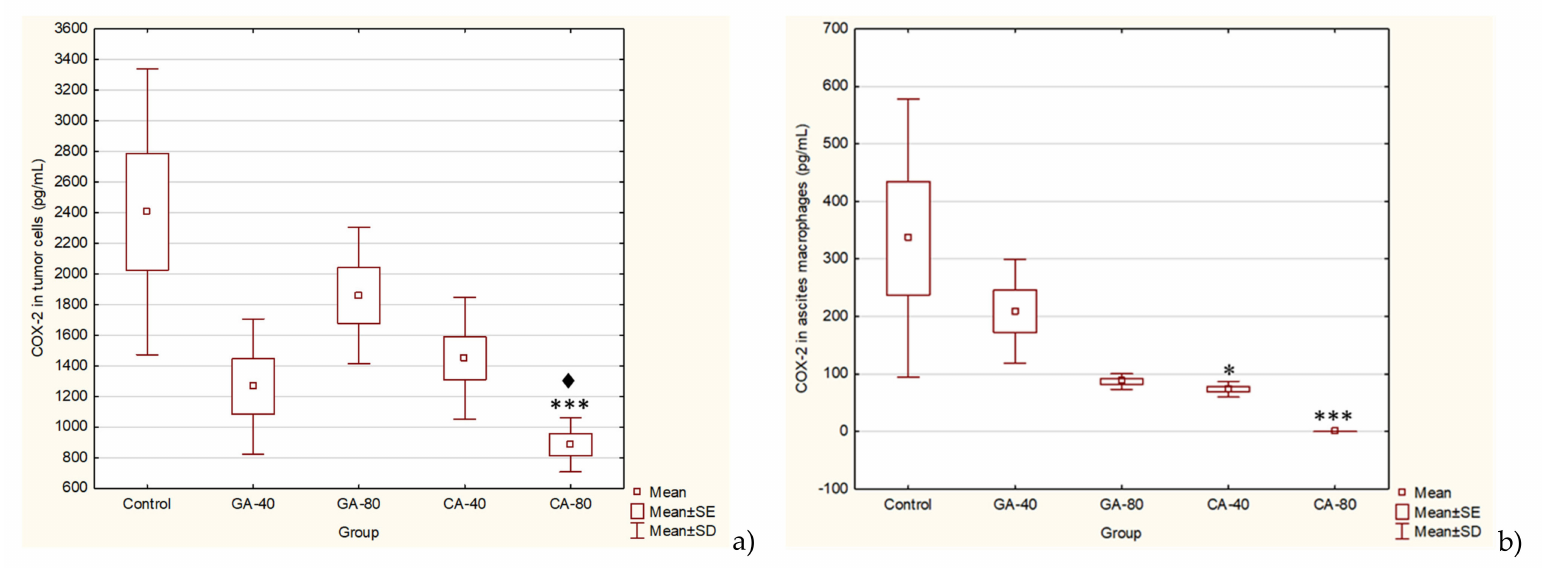
Figure 6. E ff ect of GA and CA on the COX-2 levels in tumor cells ( a ) and ascites macrophages ( b ) of mice bearing EAT. Mice were injected intraperitoneally ( ip ) with 2.5 × 10 6 viable EAT cells and treated with GA or CA at a dose of 40 mg / kg and 80 mg / kg ip in exponential tumor growth phase on days 5, 7, 9, and 11. Mice were sacrificed on the 13th day, ascitic macrophages and tumor cells were collected, and the COX-2 levels were estimated by ELISA. The results are expressed as the mean value of each experimental group ± SE of the mean of three di ff erent observations; * p < 0.05, *** p < 0.001 as compared to the control group treated with saline; (cid:7) p < 0.05 as compared to GA-40. Abbreviations: EAT, Ehrlich ascites tumor; GA, gallic acid; CA, ca ff eic